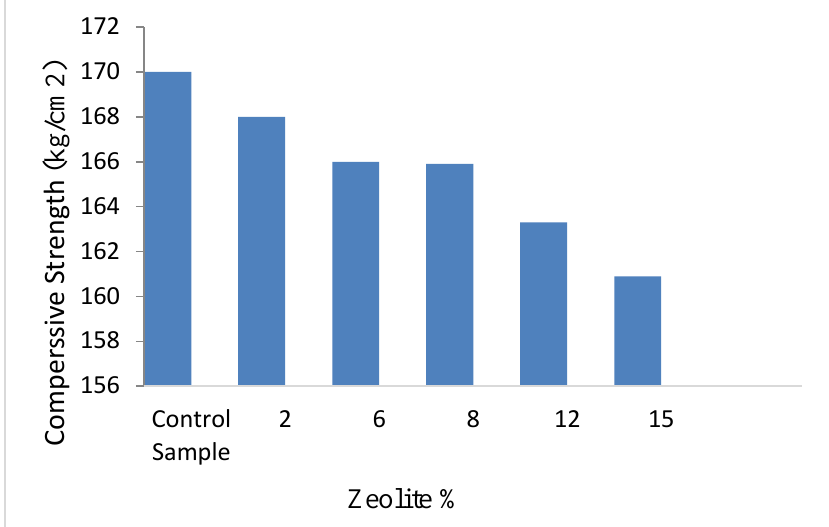
Fig. 7. Concrete strength with different percentages of Zeolite with 360 grade cement at the age of 7 days of concrete.